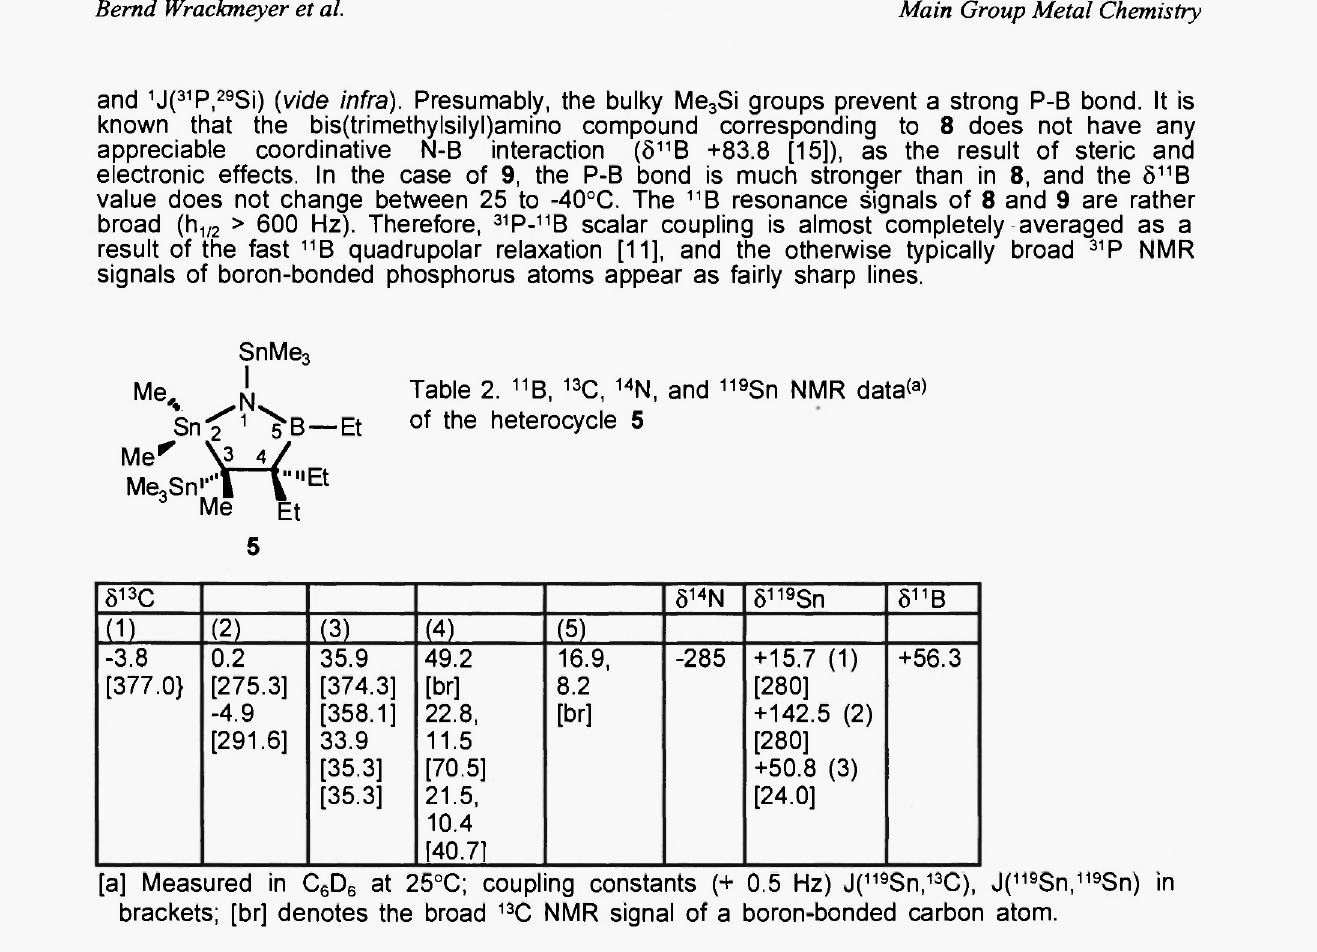
Table 2. 11 B, 13 C, 14 N, and 119 Sn NMR data< a